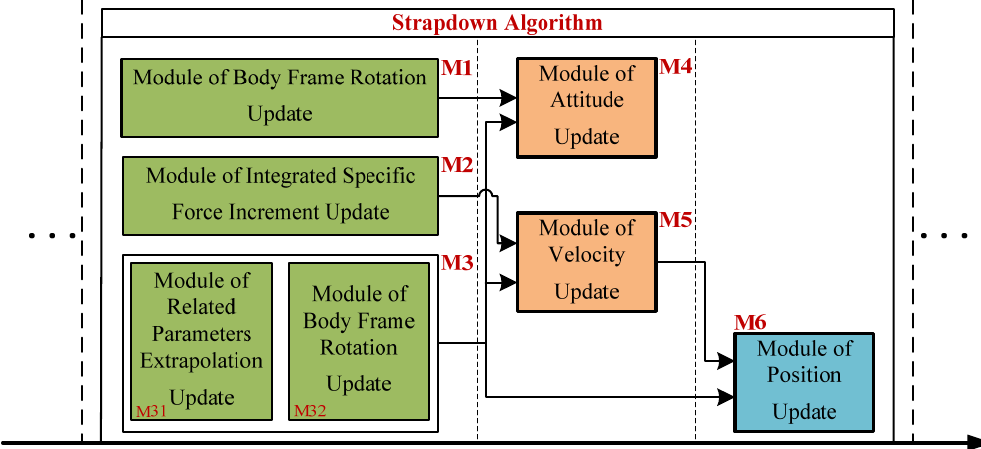
Figure 2. Functional-block diagram of parallel strapdown